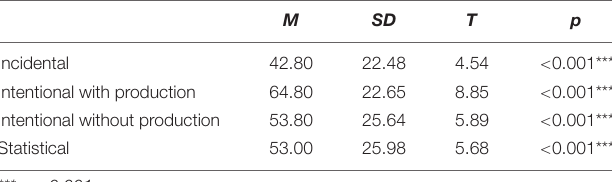
TABLE 3 | t -tests comparing the percentage of word meanings learned against a chance level of 20%.